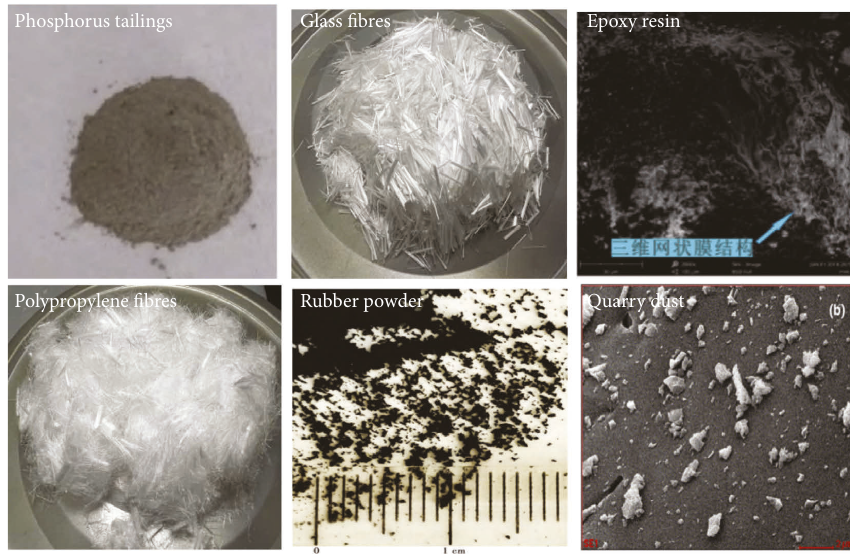
Figure 13: Solid waste